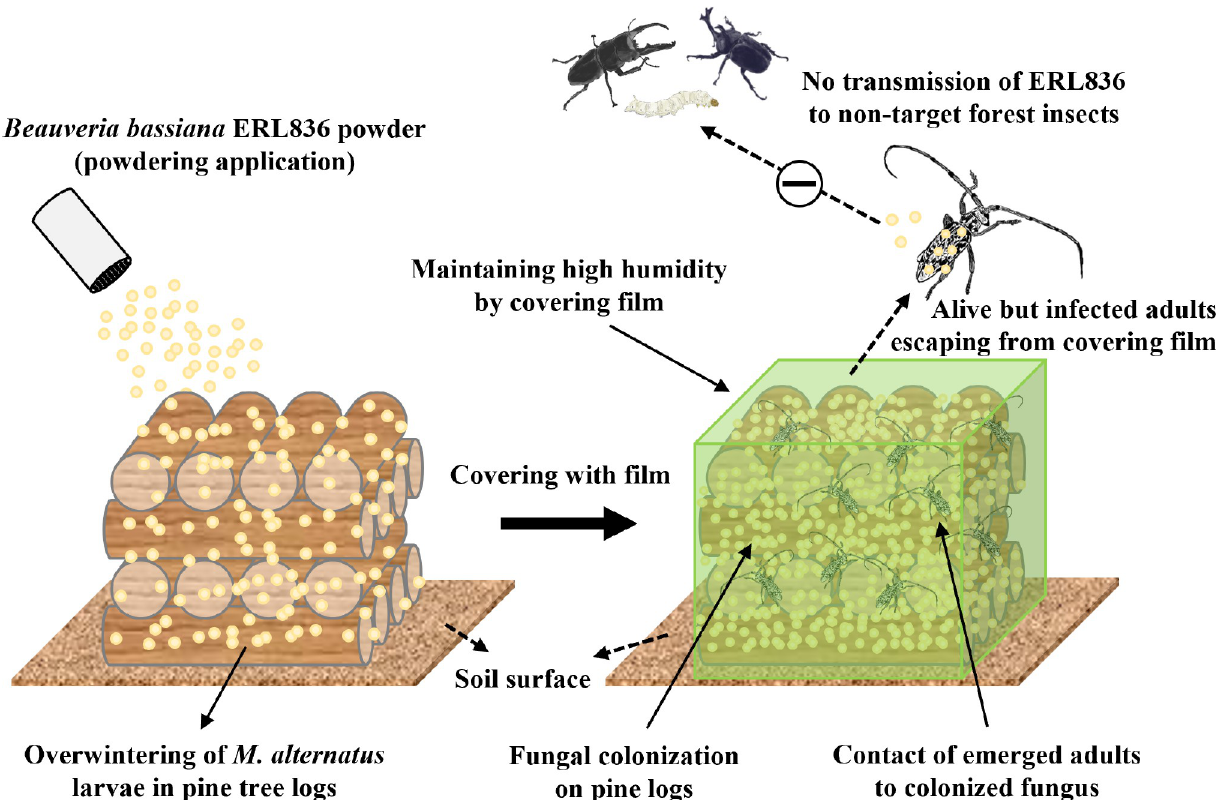
Fig 8. A schematic diagram for controlling M . alternatus by powdering overwintering pine logs with B . bassiana ERL836 fungal powder formulation. B . bassiana ERL836 can be used as a control for M . alternatus instead of chemical fumigants by simply scattering the fungal powder on pine logs and then covering them with film. The fungus can grow within the film, so it can colonize the surface of the pine logs during overwintering and spring time, and the colonized fungus has insecticidal activity against emerging M . alternatus adults. If M . alternatus adults infected with the fungus escape from the film, they are unlikely to transmit the fungus to other non–target insects in the forest, making it suitable for use as an eco–friendly control material without serious adverse effects on forest